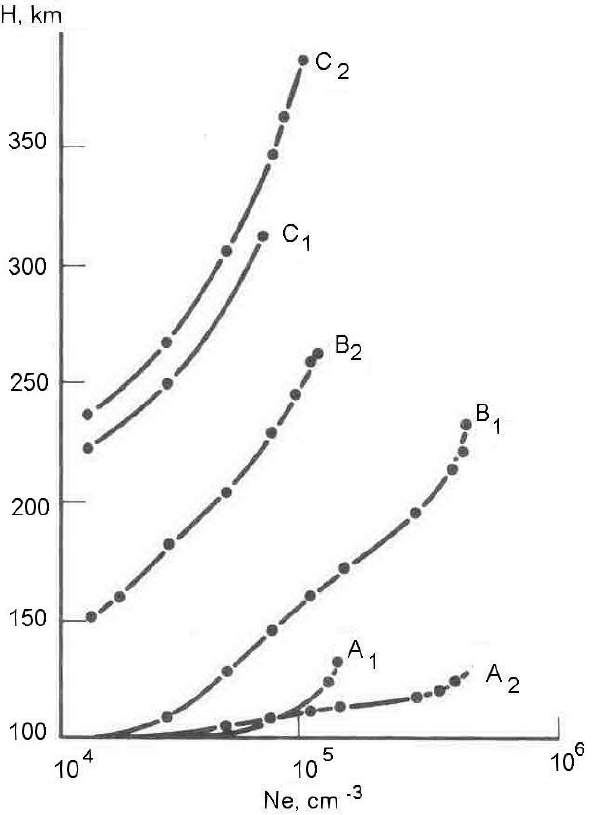
Figure 18. Ionisation profiles in different parts of the dayside iono- sphere (Vorobjev et al.,